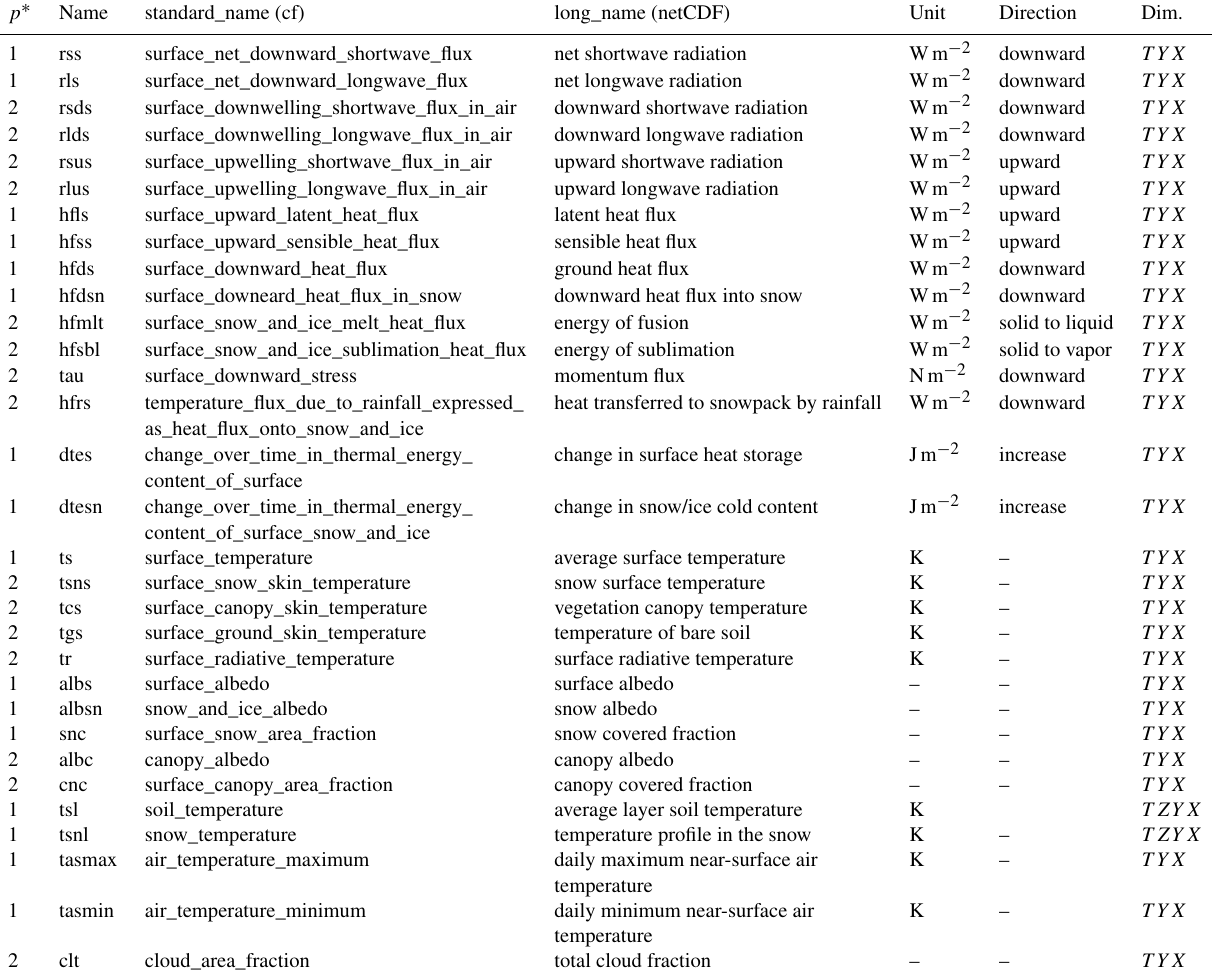
Table A1. Variable request table “LEday”: daily variables related to the energy cycle. Priority index ( p ∗ ) in column 1 indicates 1: “Manda- tory” and 2: “Desirable”. The dimension (dim.) column indicates T : time, Y : latitude, X : longitude, and Z : soil or snow layers. “Direction” identifies the direction of positive